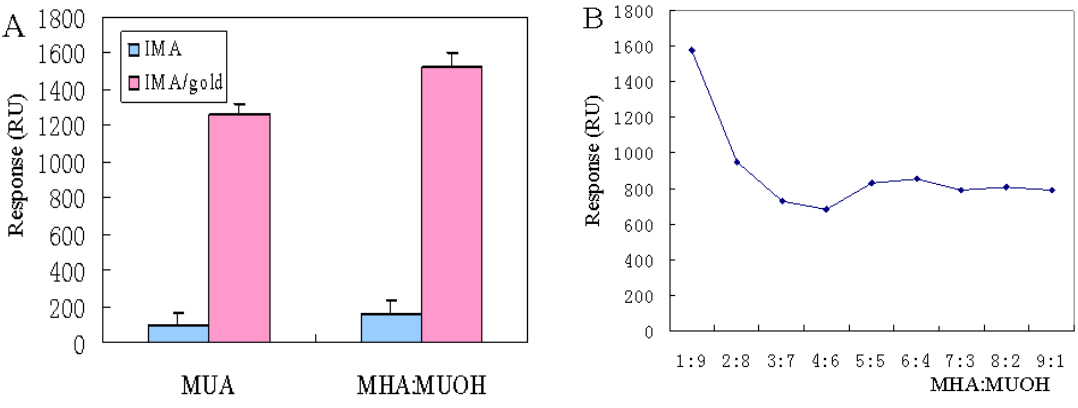
Figure 2. Effects of MUA and MHA/MUOH mixed self-assembled chips on surface for Format A (IMA 100 µg/L) and B (IMA-AuNP complex, 100 µg/L IMA, AuNP size 10 nm) ( A ) and the changing proportion of MHA:MUOH from 1:9, 2:8, 3:7, 4:6, 5:5, 6:4, 7:3, 8:2 to 9:1. ( B ) The experiments of graphic (B) were achieved employing Format